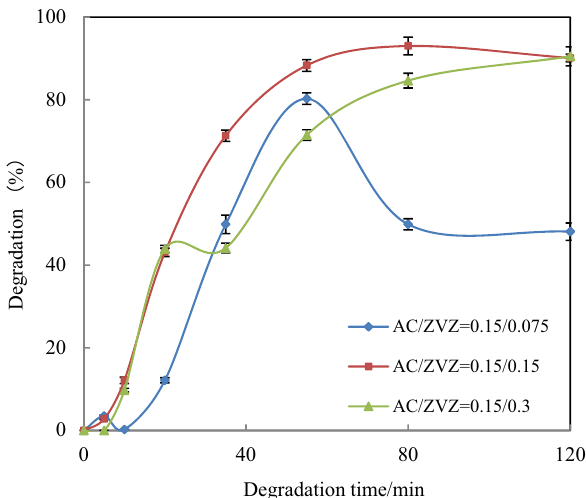
Figure 2. Effect of ratios of AC and ZVZ on [C 4 mim][BF 4 ] degradation. ([[C 4 mim][BF 4 ]] = 1 mmol/L, pH = 3.0 and ultrasound frequency = 45 kHz at 30 °C).